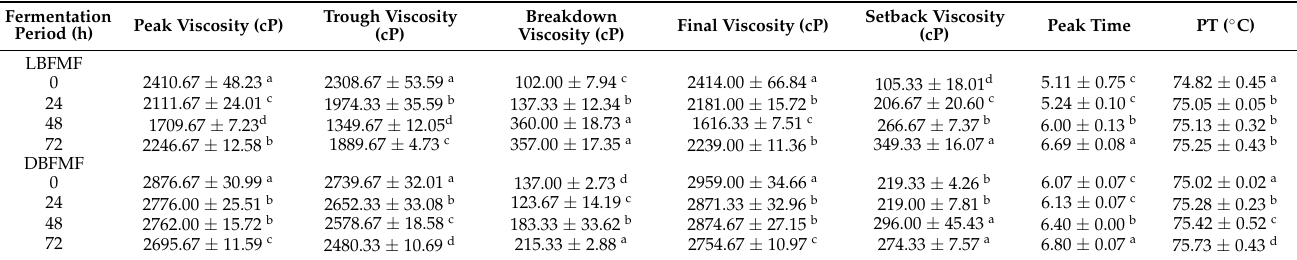
Table 4. Pasting properties of spontaneously fermented finger millet